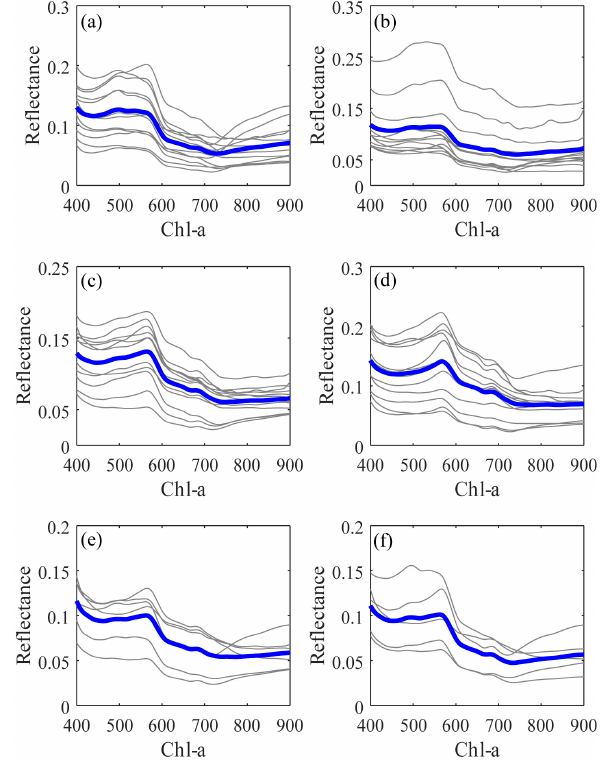
Figure 7. Water-leaving reflectance ( R L ) spectra with the spectra average (blue line) for each station (( a – f ) are stations 1 to 6 in turn).